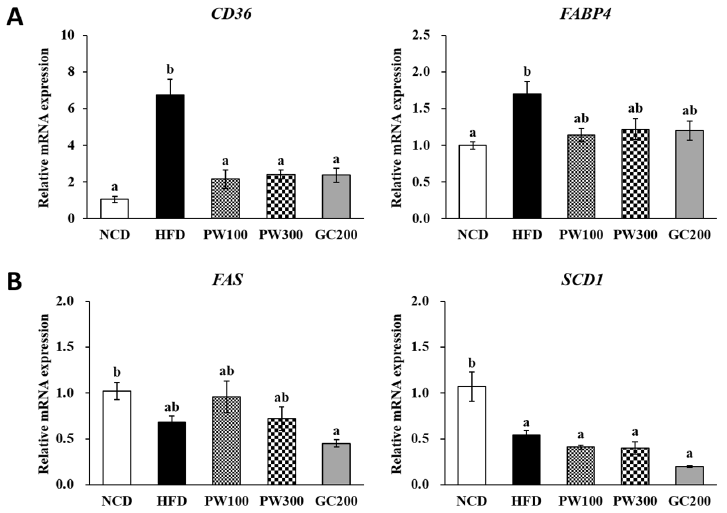
Figure 4. Effects of Polygonum multiflorum Thunb. hot water extract on FA uptake ( A ) and FA synthesis ( B )-related gene expression in interscapular BAT in HFD-induced obese mice. Data are expressed as means ± SE. Values with different superscript letters are significantly different at p < 0.05 as determined by one-way ANOVA followed by Tukey’s HSD test.